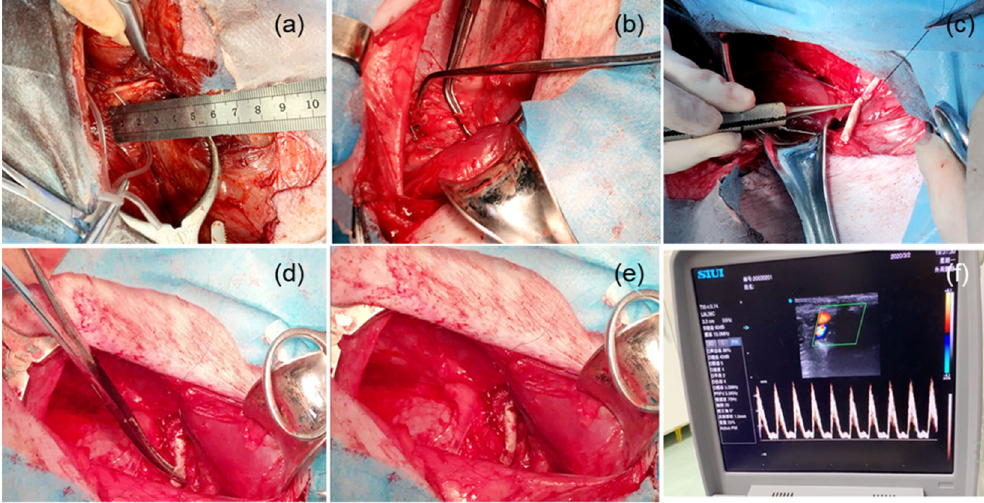
Fig. 11 Implantation of a bioarti fi cial blood vessel in a pig: a Exposure of the left posterior femoral artery. b Peeling and clamping of the femoral artery. c Surgical suturing of the bioarti fi cial blood